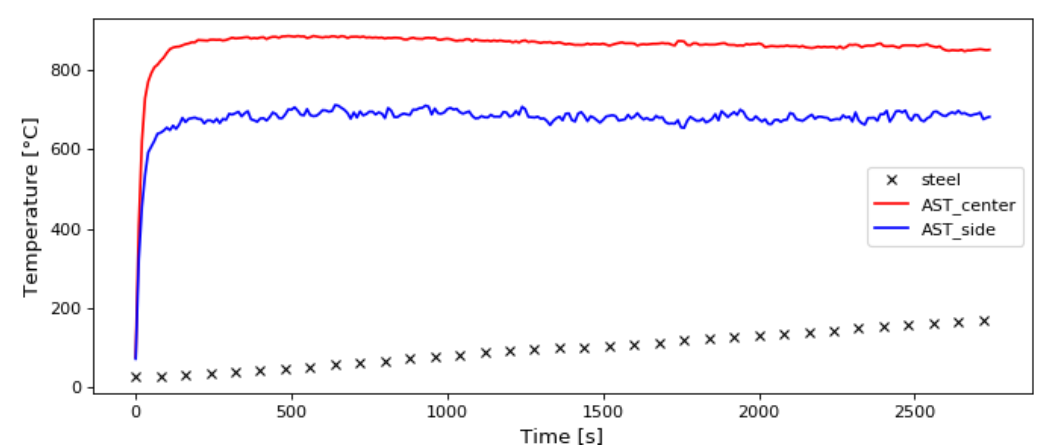
Figure 9. Adiabatic surface temperatures from the thermocouples and temperature of the steel element.